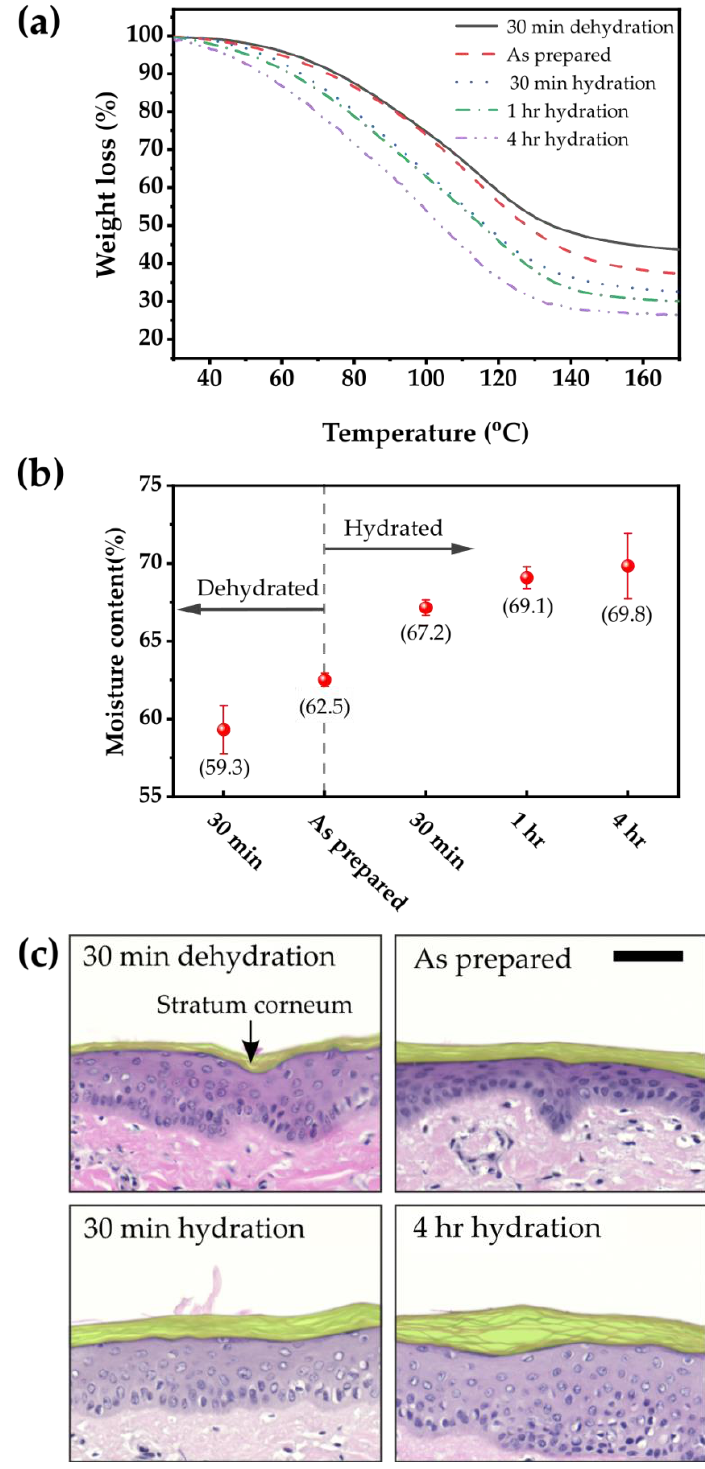
Figure 3. ( a ) TGA curves and ( b ) the measured moisture contents of dehydrated or hydrated por- cine skin. ( c ) Histological images of porcine skin with various moisture contents. The scale bar is 50